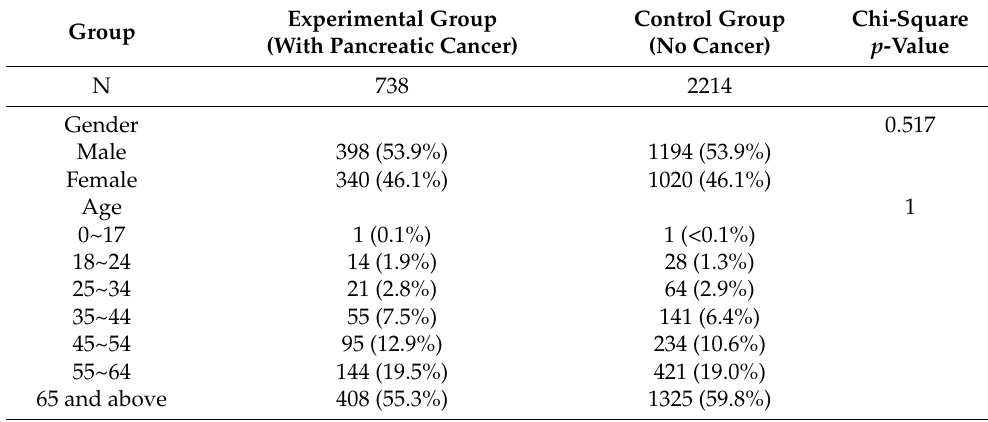
Table 1. Demographics of the study group.